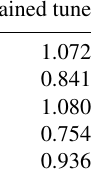
Table 5. The percentage of standard deviation of the eight fields between the CNTL run and the optimal model run with constrained optimization according to the corresponding